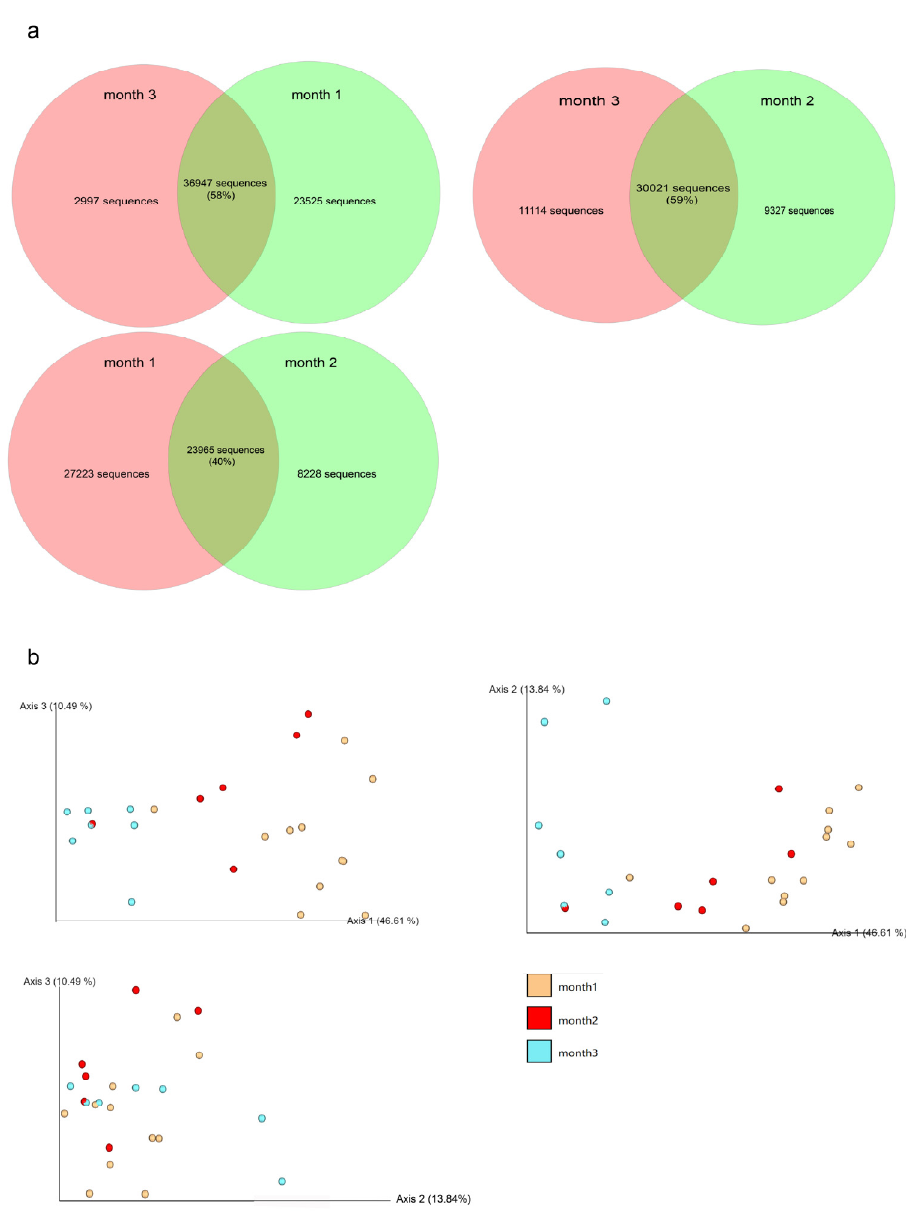
Figure 7. The effect of ferment times on microbial community composition. ( a ) Venn diagram showing unique and shared sequences of bacterial communities at different fermentation times. ( b ) Principal coordinate analysis of the bacterial community during the fermentation of sour tea. The analysis was conducted using the unweighted UniFrac method.